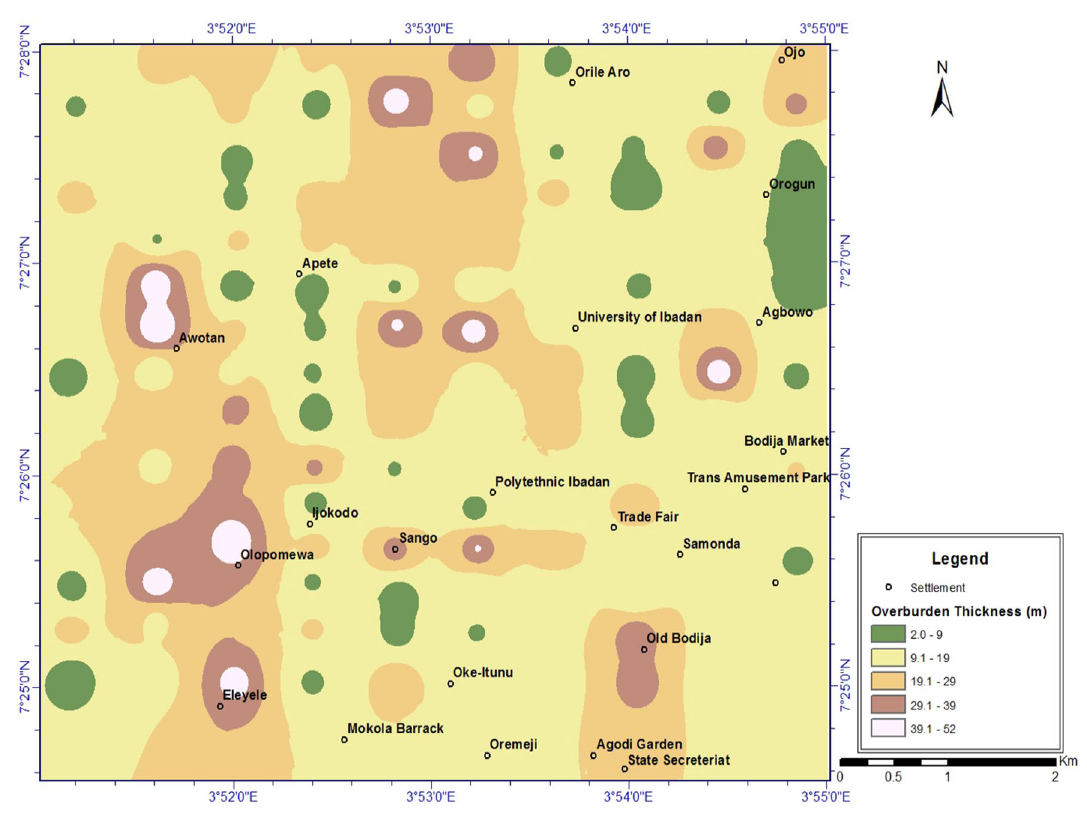
Fig. 12 Overburden thickness map of the study area Fig. 13 Aquifer resistivity map of the study